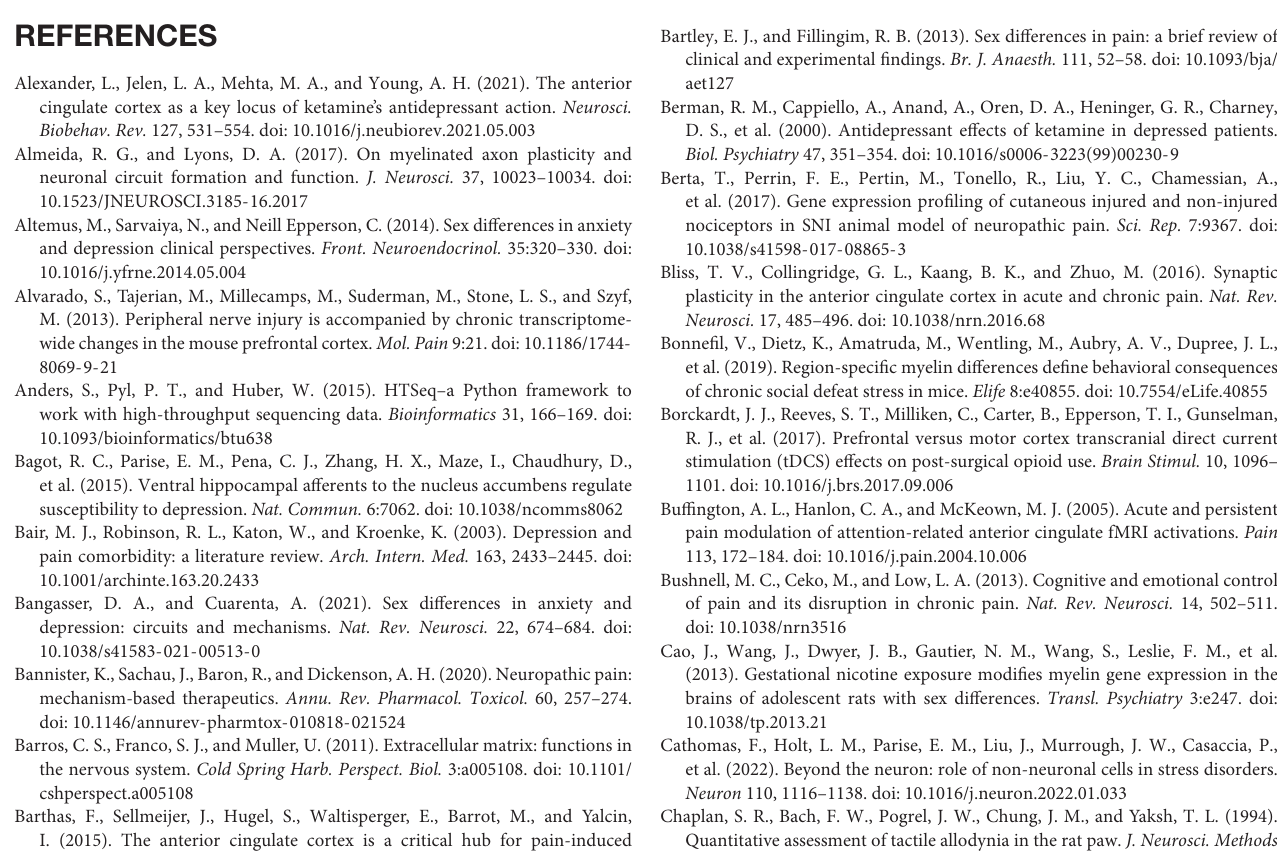
Supplementary Table 1 | List of primers used in the qPCR validation of RNAseq results. Supplementary Table 2 | List of the DEGs in the mPFC and the ACC of female and male mice, comparing the sham versus the SNI groups. Supplementary Table 3 | Gene set enrichment analysis results for the mPFC and the ACC of female and male mice, comparing the sham versus the SNI groups. Supplementary Table 4 | List of the DEGs comparing the mPFC versus the ACC in the female and male mice of the sham groups. Supplementary Table 5 | Gene set enrichment analysis results for the female and male mice, comparing the mPFC versus the ACC in the sham groups. Supplementary Table 6 | List of the DEGs in the mPFC and the ACC, comparing female and male mice of the sham groups. Supplementary Table 7 | Gene set enrichment analysis results for the mPFC and the ACC, comparing female and male mice of the sham